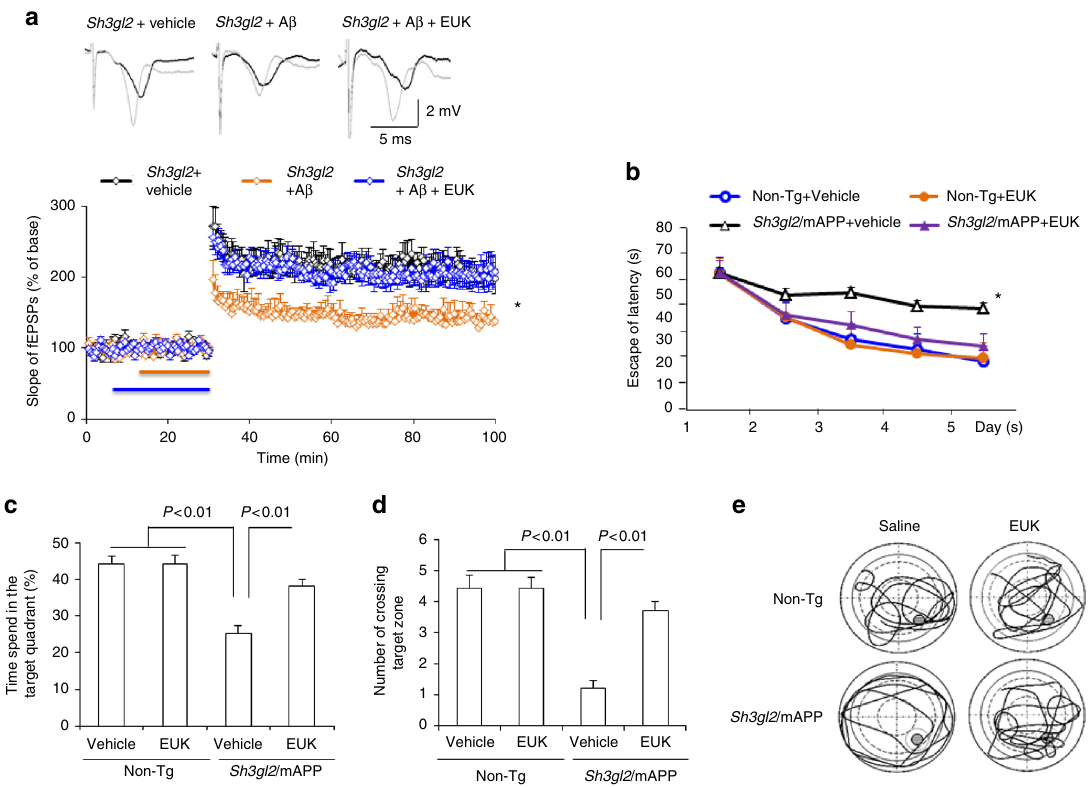
Fig. 7 Effect of ROS scavenger on EP/A β -mediated synaptic plasticity and spatial learning and memory impairment. a Hippocampal slices from 5-month- old to 6-month-old Tg Sh3gl2 mice were pretreated with EUK-134 (500 nM) for 5 min before A β perfusion (100 nM for 20 min), and then hippocampal CA3-CA1 LTP was recorded. Error bars represent s.e.m., n = 7 – 10 per group. * p < 0.01 (one-way ANOVA). Non-Tg and Tg Sh3gl2 /mAPP mice were intraperitoneal injected with EUK-134 (2 mg/kg) once a day for 3 weeks and then performed a Morris water maze test at 5 – 5.5 months of age. Upper panel shows representative traces of fEPSP in slices with the indicated treatment before θ -burst stimulation (black line) and after 1 h (gray line). b Escape latencies in hidden platform during Morris water maze task training in indicated groups. Error bars represent s.e.m., n = 8 – 9 per group. * p < 0.01 (one-way ANOVA). c Time spent in the quadrant with the hidden platform and d mean number of crossings of the target during the probe test. e Representative searching traces during the probe test. Learning and memory were impaired in Tg Sh3gl2 /mAPP mice compared to other groups, which was rescued by antioxidant EUK treatment. Data are shown as mean ± s.e.m., n = 8 – 9 mice per group (one-way ANOVA in c , d